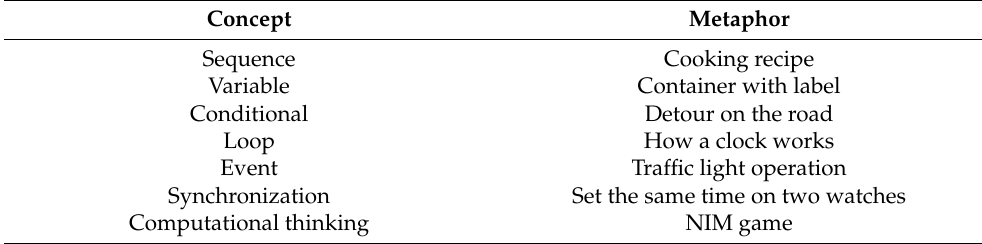
Table 2. Metaphors of programming concepts in the Guided Scratch